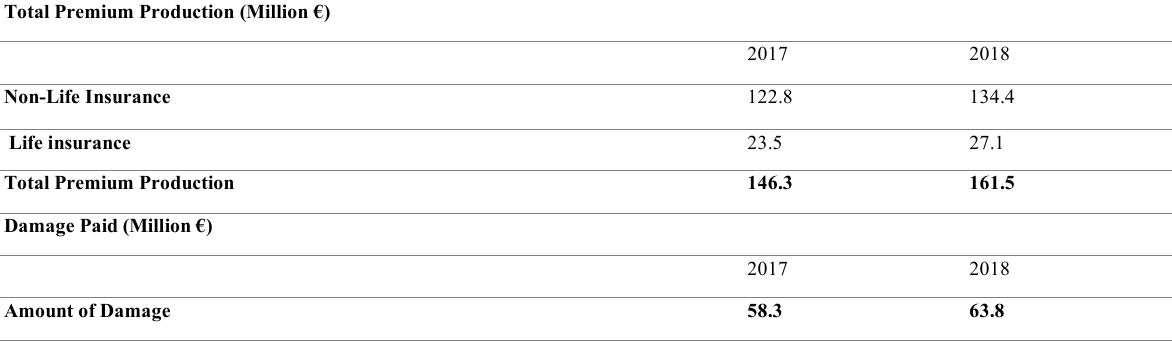
Table 3: Total Insurance Premium and Total Claims Paid